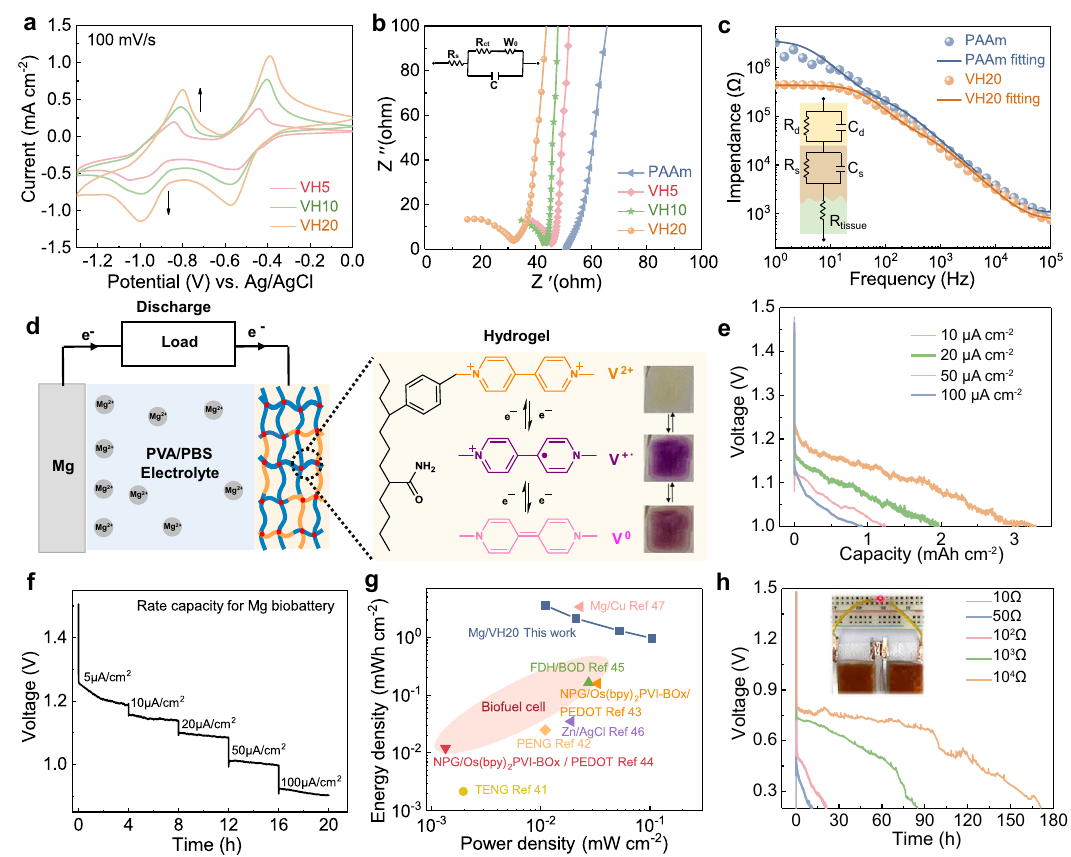
Fig. 3 | ElectrochemicalpropertiesofP(AM-co-SV)hydrogelsandMgbatteries. a CVofP(AM-co-SV)hydrogelsonITOelectrodein0.01MPBSsolutionwithascan rate of 100mVs – 1 . b Nyquist plots of P(AM-co-SV) hydrogels on ITO electrode in 0.01M PBS solution. c EIS analysis of the tissue impedance of PAAm and VH20 hydrogels interfaced with the forearm skin (inset, equivalent circuit model). d Schematic diagram of the Mg battery using VH20 cathode and PVA/PBS gel